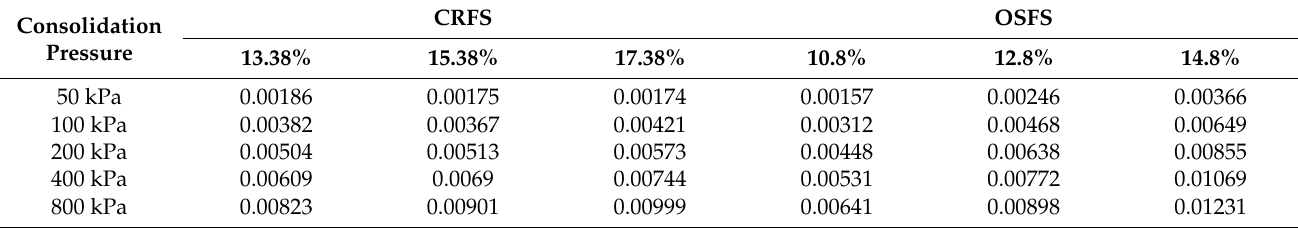
Table 4. Secondary consolidation coefficient of modified soil with different water contents.